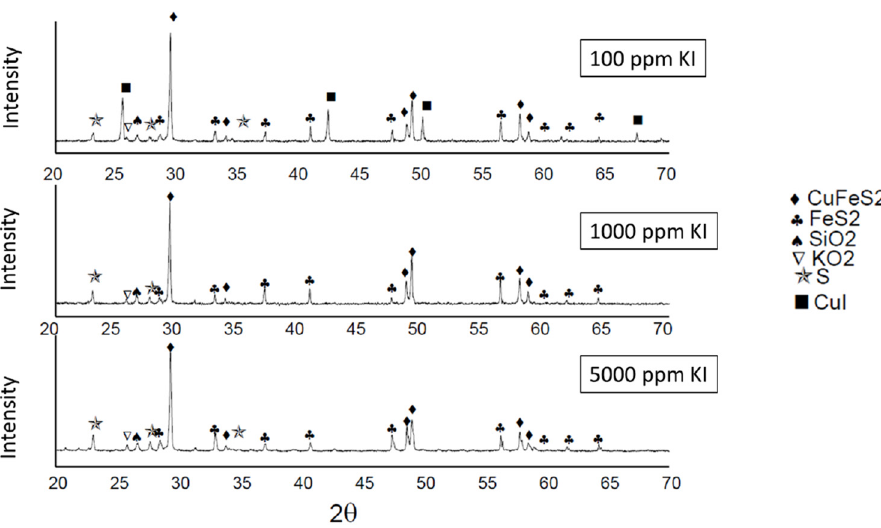
Figure 13. Diffractograms of the leaching tests using 100, 1000, and 5000 ppm KI with 0.5 M H 2 SO 4 . 1000 ppm KI–0.5 M H 2 SO 4 , and 5000 ppm KI–0.5 M H 2 SO 4 . Therefore, the diffractograms